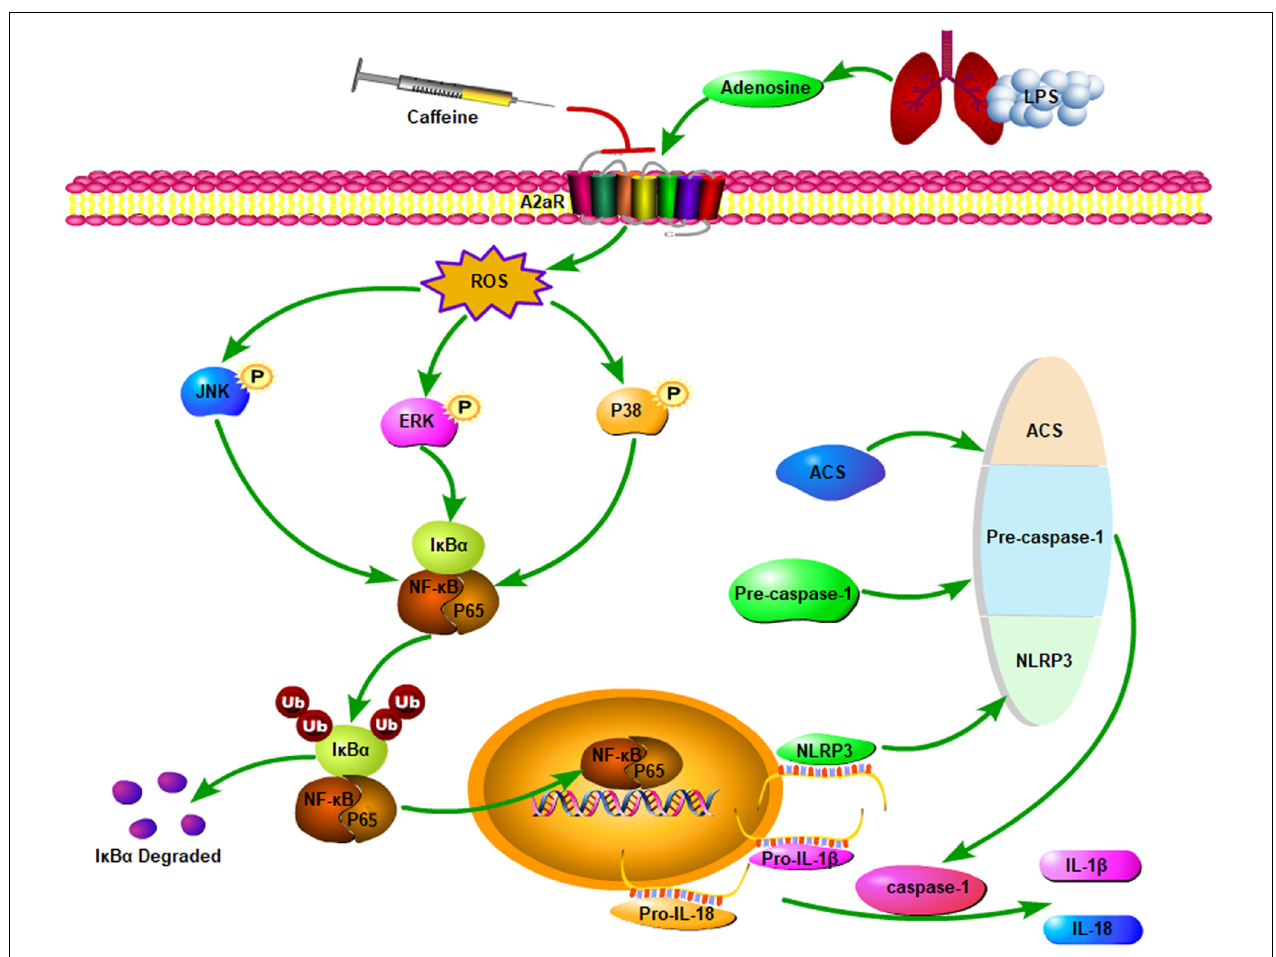
FIGURE 3 | Caffeine antagonism of A2aR reduces ROS production and subsequent phosphorylation levels of MAPK and NF- κ B pathway members, thus inhibiting NF- κ B translocation to the nucleus and reducing NLRP3 expression, ASC speck formation, and caspase-1 cleavage. This ultimately leads to a reduction in the secretion of IL-18 and IL-1 β . A2aR, adenosine 2a receptor; LPS, lipopolysaccharide; ROS, reactive oxygen species; ERK, extracellular regulated protein kinases; JNK, c-Jun N-terminal kinase; NLRP3, nucleotide-binding domain and leucine-rich repeat protein 3; ACS, apoptosis associated speck-like protein containing a CARD; NF- κ B, nuclear factor kappa-light-chain-enhancer of activated B cells; I κ B, inhibitor of κ B; IL,